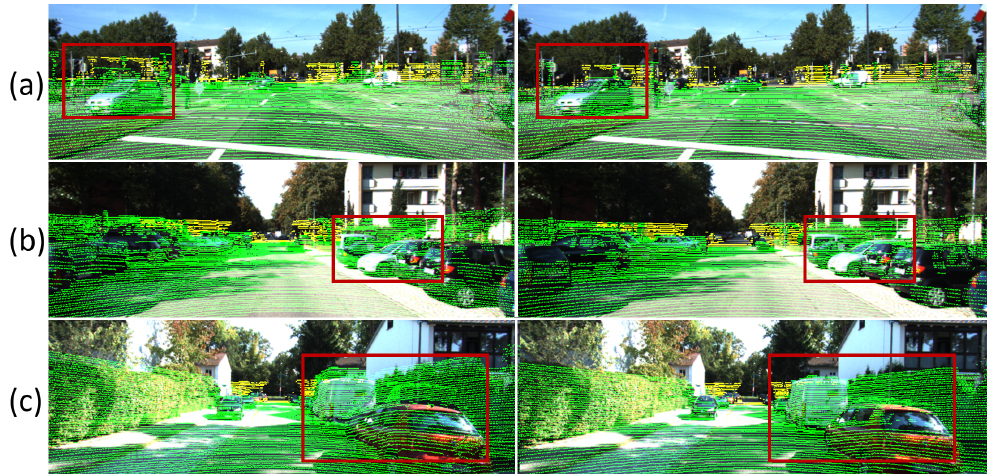
Figure 7. Comparisons with the baseline-1 ( left ) and baseline-5 ( right ) in the validation dataset for the various outdoor scenes ( a – c ). Comparing the alignment of LiDAR points and RGB pixels of the objects in the red boxes, baseline-5 has the smaller alignment errors. The projected LiDAR point cloud with pseudo color depended on LiDAR intensity is used for visualization.